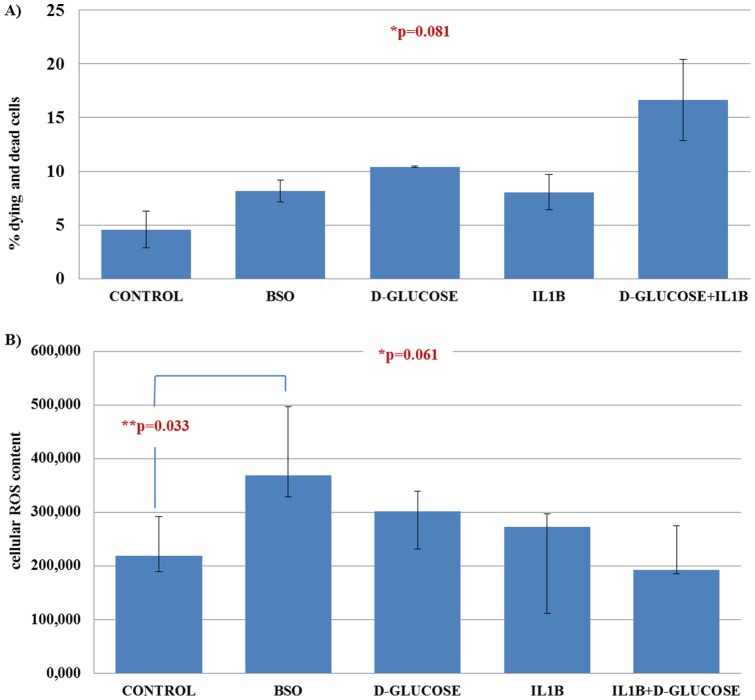
The cell death and intracellular ROS content as measured by flow cytometry after 7 days of culture in each treatment.The percentage of dying and dead cells is shown in panel A and the intracellular ROS content of viable cells in panel B. 
Figure 4

footnote: Due to the small number of measurements, normal distribution cannot be inferred. Thus, the graph represents median values, with inter-quartile range as error bars. *P value is obtained from Kruskal-Wallis test. **P value is obtained from Mann-Whitney test. Mann-Whitney tests between the percentages of dying and dead cells in each of the treatments compared with the control were non-significant (p = 0.121).